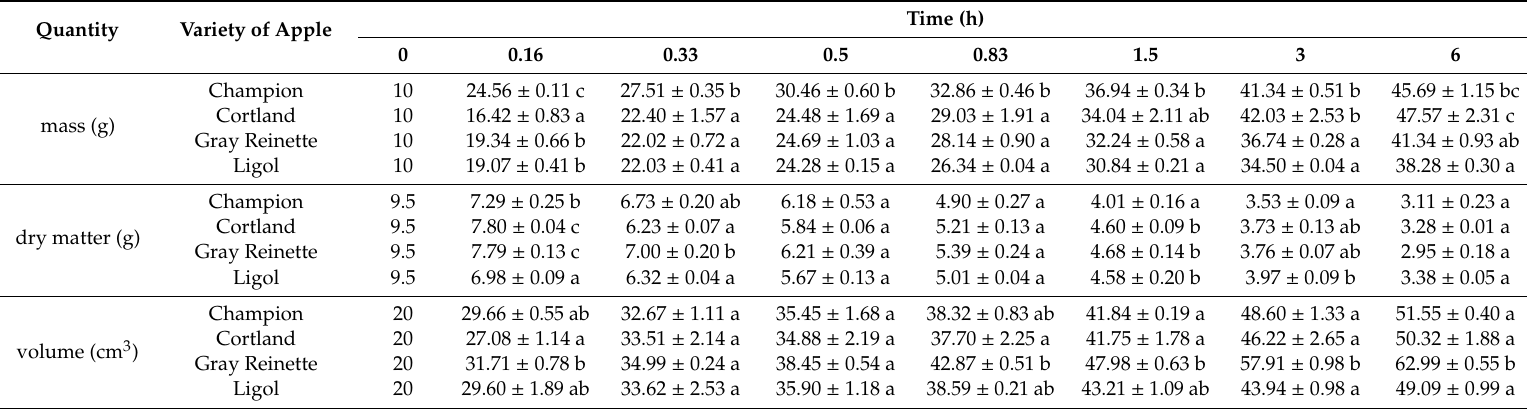
Values for the same quantity, followed by di ff erent letters in the same column, are significantly di ff erent at the 5% level (Tukey’s test